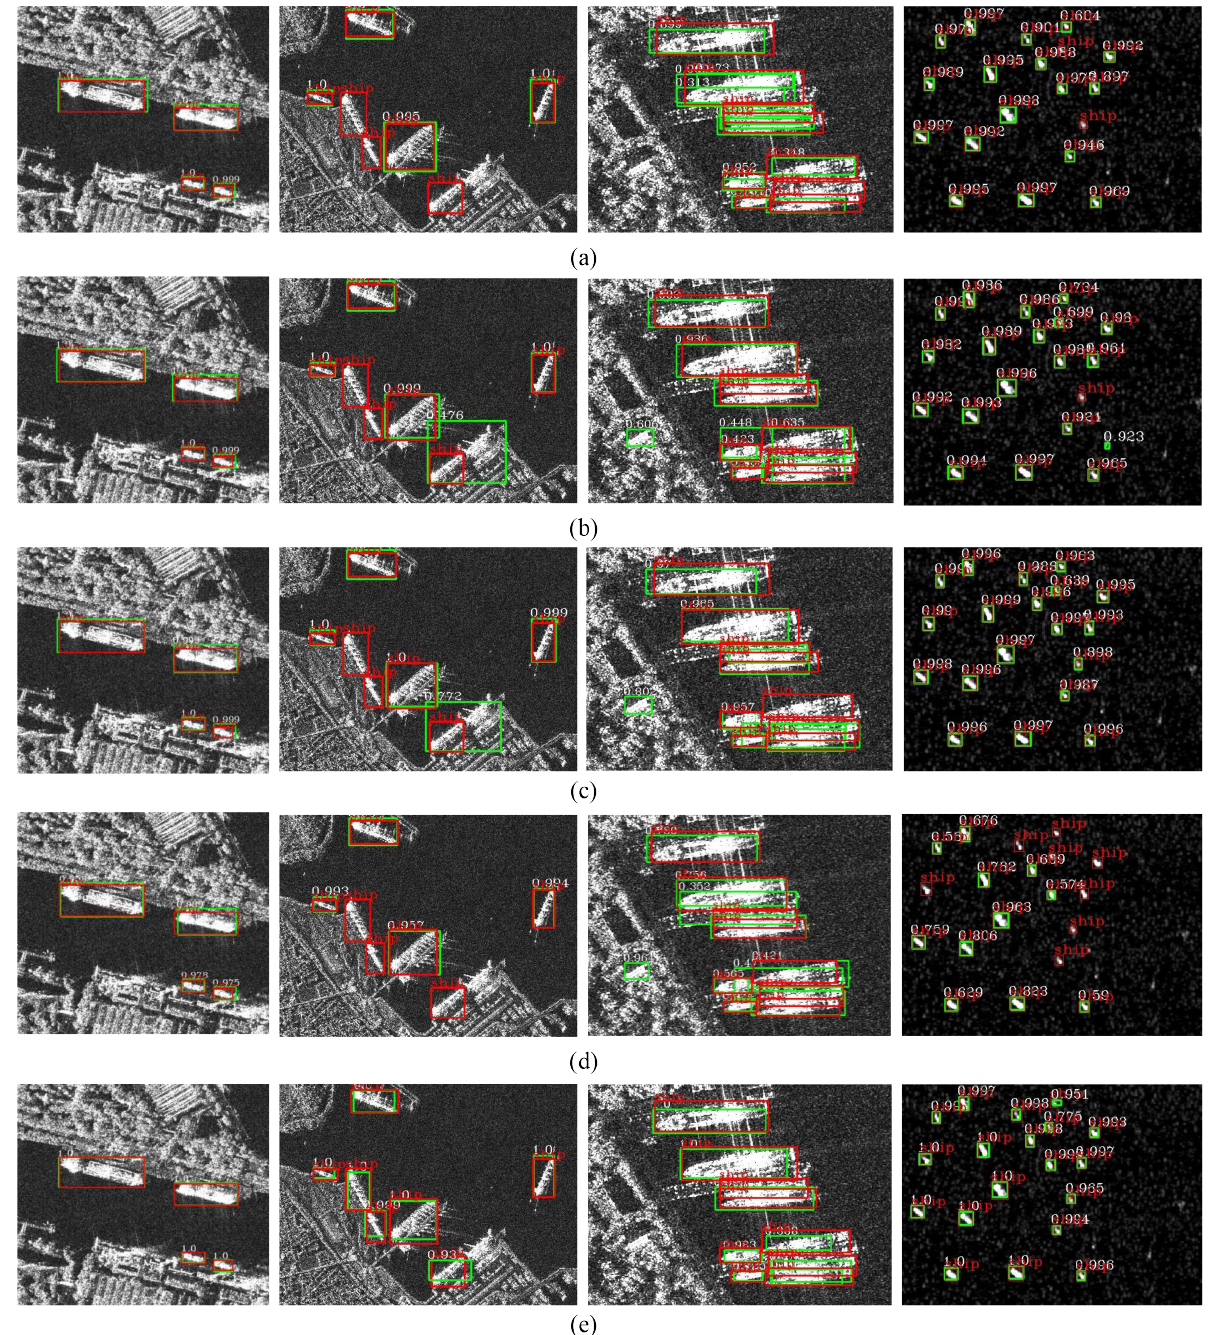
Figure 8. Comparison detection results of different methods in the inshore and offshore scenes of the SSDD dataset. ( a ) Detection results of the Faster R-CNN. ( b ) Detection results of the Double-Head R-CNN. ( c ) Detection results of the PANet. ( d ) Detection results of the RetinaNet. ( e ) Detection results of the ASAFE. Green bounding boxes denote the detection results. Red bounding boxes denote the ground-truth